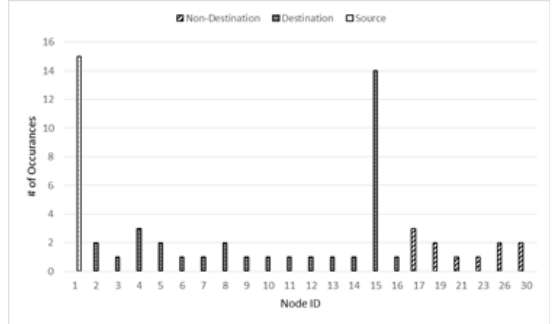
Fig. 16. Number of Paths Each Node Participates in for a Multicast Tree with 30 Nodes and 15 Destinations